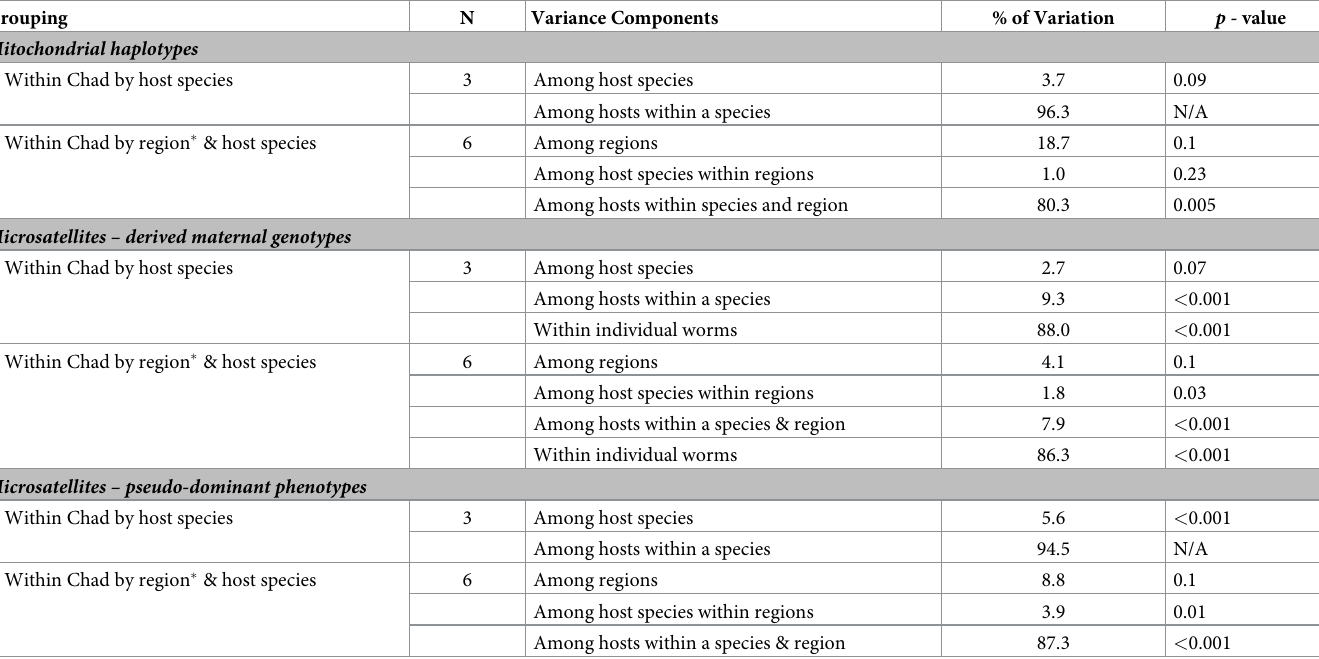
Table 3. Analysis of molecular variance (AMOVA) of Chadian D . medinensis among host species and broad geographic origin.